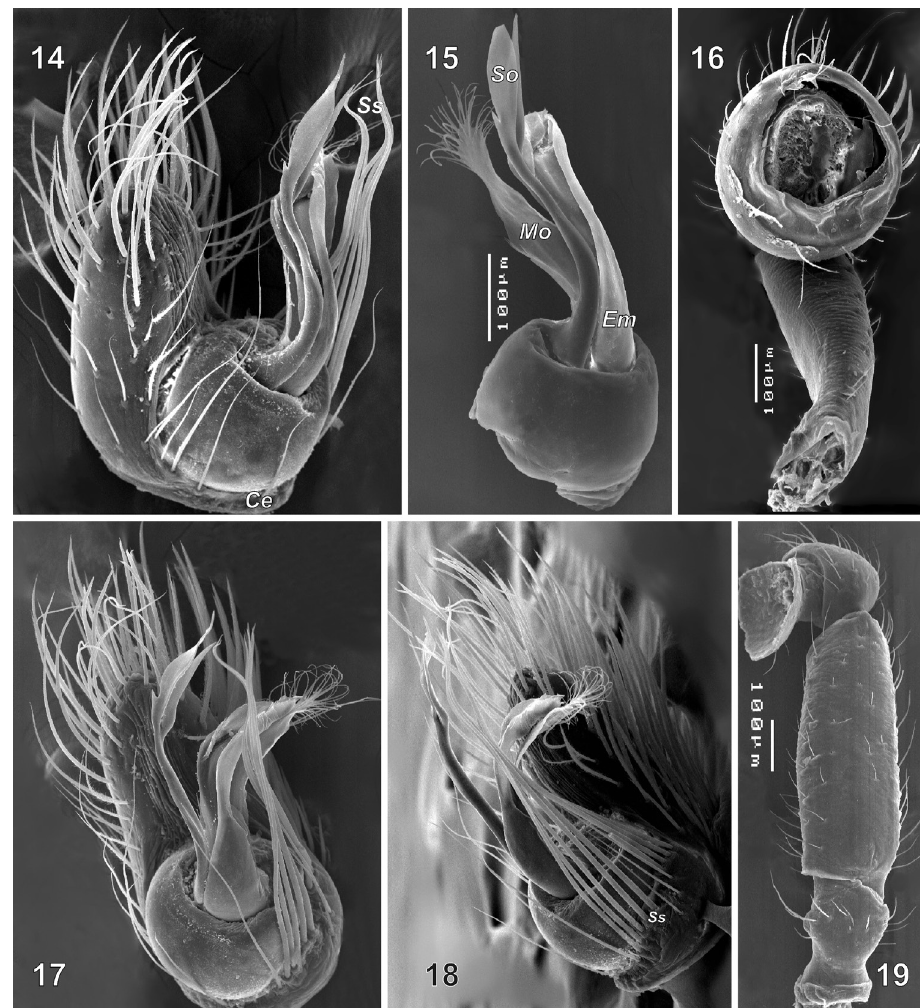
Figures 14–19. Details of male palp of Diaphorocellus biplagiatus. 14, 17–18 cymbium and bulb, prolateral, ventro-prolateral (from above) and retrolateral 15 bulb, prolateral 16 femur and tibia, ventral 19 trochanter, femur and patella, retrolateral. Abbreviations: Ce base of cymbium encircling bulb; Cs strong cymbial setae; Em “embolus”; Mo membranous outgrowth; So sclerotised outgrowth. and large, transparent, membranous sac ( Rs ). Base of receptacle accompanied with ap- proximately 10 grape-shaped glands ( Gg ) attached to receptacles by long thread-like stems and brushes of fine threads ( Ft ). Base of receptacle subconical, anterior part of receptacle with dark area ( Da ) composed of numerous pores. Base of receptacle and grape-shaped gland covered with small thread-like cilia. Cilia ( Cg ) on glands shorter and originating from pore-like